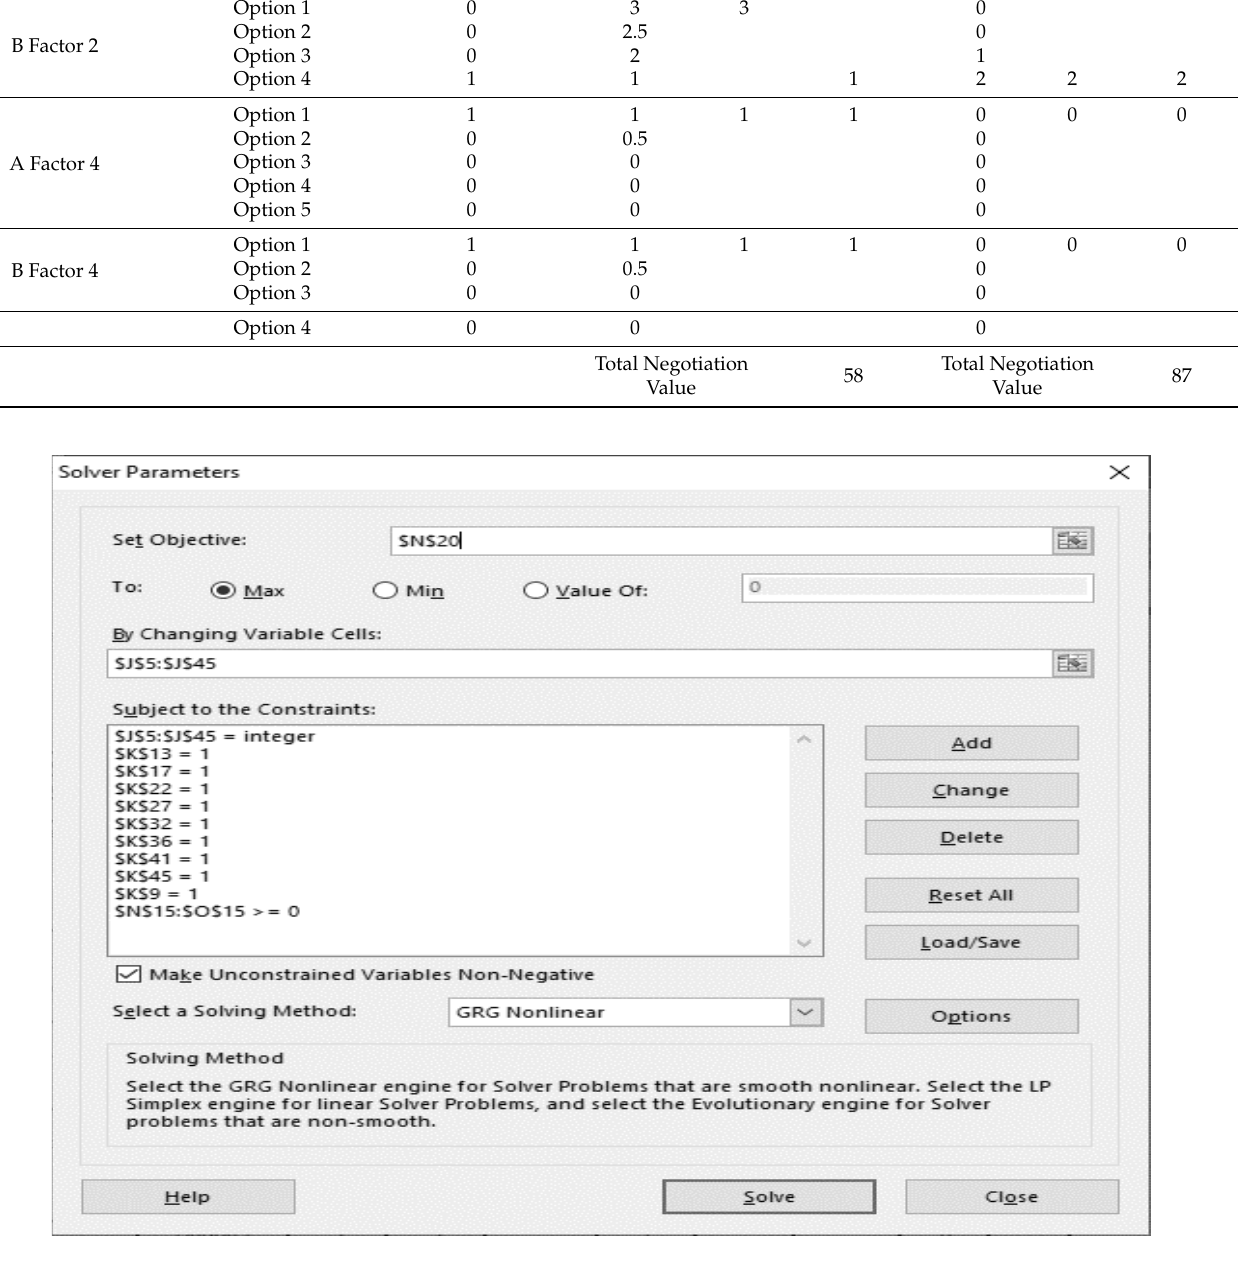
Figure 2. Solver objective and constraints of Nash solution model. Table 7. Nash solution of the negotiation score of FP and SP from the Solver software.